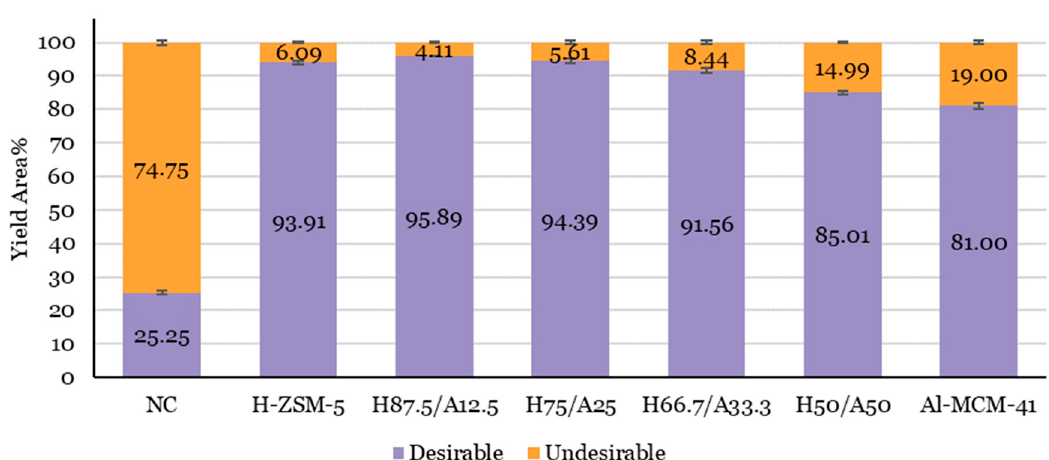
Figure 4. The chemical composition (area%, on dry basis (odb)) of OF for lignocellulose biomass catalytic pyrolysis with di ff erent proportions of H-ZSM-5 and Al-MCM-41. A non-catalytic case is included as a reference case. Yield Area (%) Desirable = area hydrocarbons (aliphatic, BTX, naphthalene, styrene, other aromatics) % + area phenols % + area furans % + area alcohols %. Yield Area (%) Undesirable = area PAHs % + area ethers % + area aldehydes % + area ketones % + area acids and esters % + area carboxylic % + area amines and amides % + area others (unidentified compounds) %. Data was taken from Table 3.